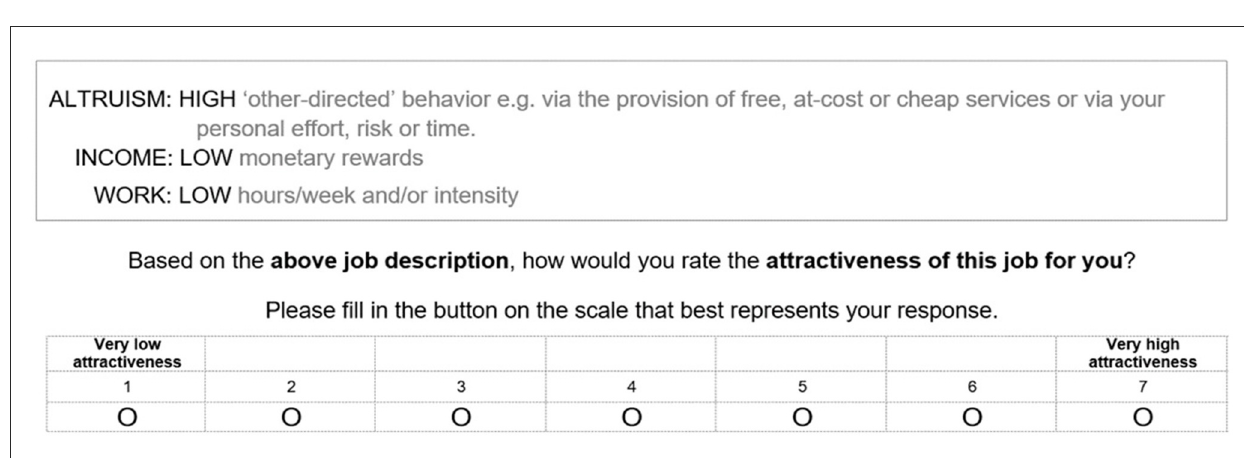
FIGURE1 Example profile showing attribute prompts and the seven-point rating scale for one of the hypothetical job profiles in the conjoint experiment.